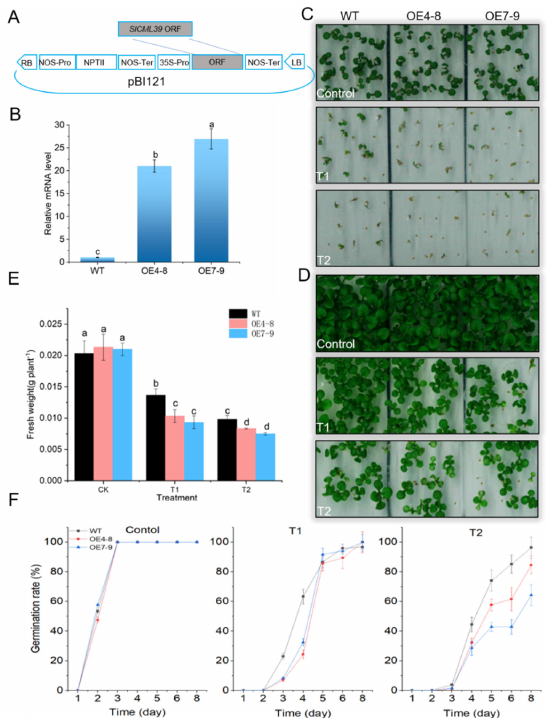
Figure 6. Overexpression of SlCML39 increases the sensitivity of Arabidopsis thaliana seed germi- nation to high temperature (HT). ( A ) Schematic diagram of the SlCML39 expression vector. The coding region of SlCML39 was cloned in the expression vector pBI121. ( B ) The mRNA levels of SlCML39 in WT and two SlCML39-overexpressing transgenic lines, OE4-8 and OE7-9, using qRT-PCR. ACTIN gene was used as an internal control. ( C ) Seed germination of WT and SlCML39-overexpressing lines on 1/2 MS medium after HT. Dry seeds were immersed at 52 ◦ C for 15 (T1) and 25 min (T2), then steril- ized on the surface before sowing. The germination rate within 8 days was calculated. The phenotype under light for 4 days is shown. ( D ) Post-germinated growth of WT and SlCML39-overexpressing lines on 1/2 MS medium after HT for 14 days. ( E ) The fresh weight of ( D ). ( F ) The germination rates of ( C ). The bar represents the mean ± SD values of three replicates ( n = 3). According to the LSD test, the statistical differences between samples are marked with different letters ( p <